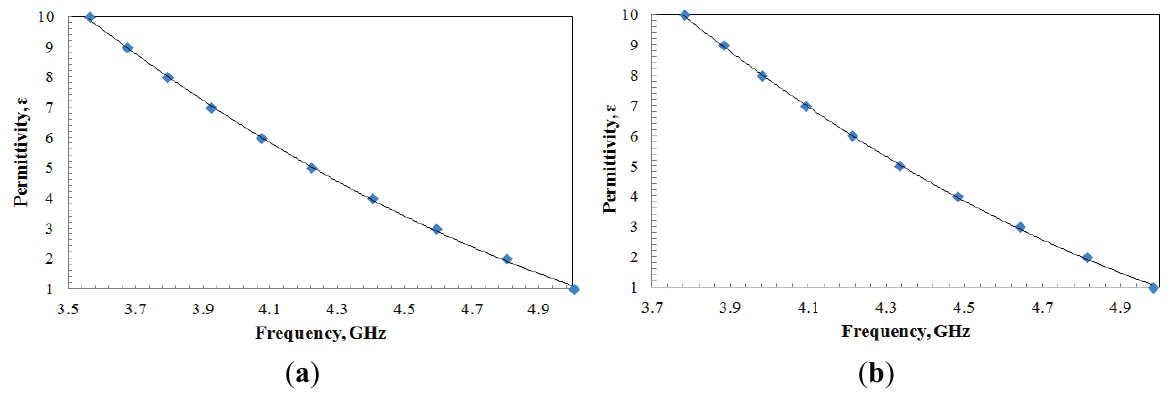
) versus sample permittivity for ( a ) aligned-gap multi-ring; 0